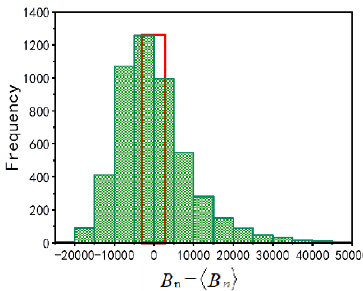
Figure 2. Frequency statistics histogram of ( B n − (cid:104) B n (cid:105) ) . The red box represents the approximate range of data we deleted.